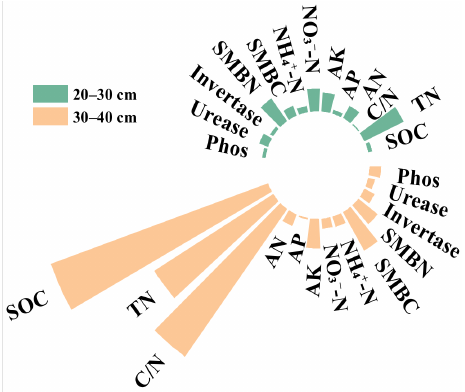
Figure 9. Contributions of soil nutrients to maize yield at 20–30 cm and 30–40